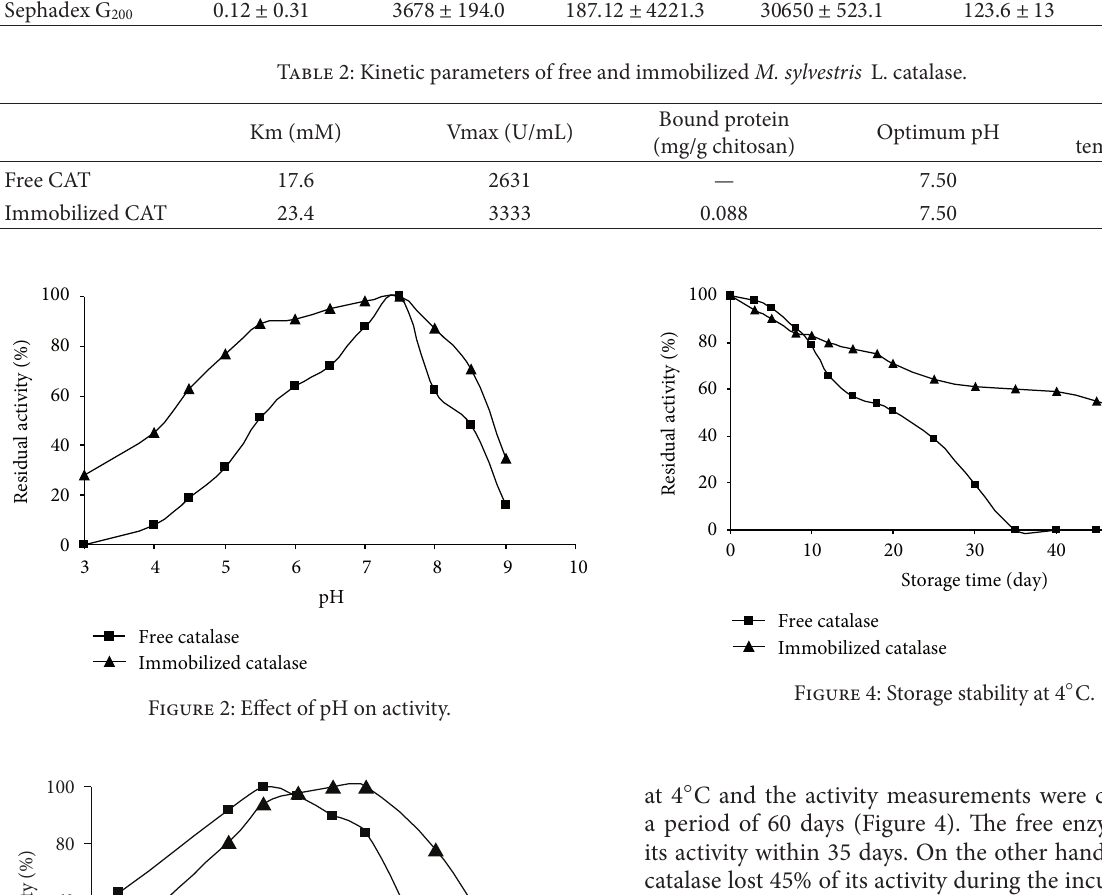
phosphate buffer (50 mM, pH 7.0) at 25